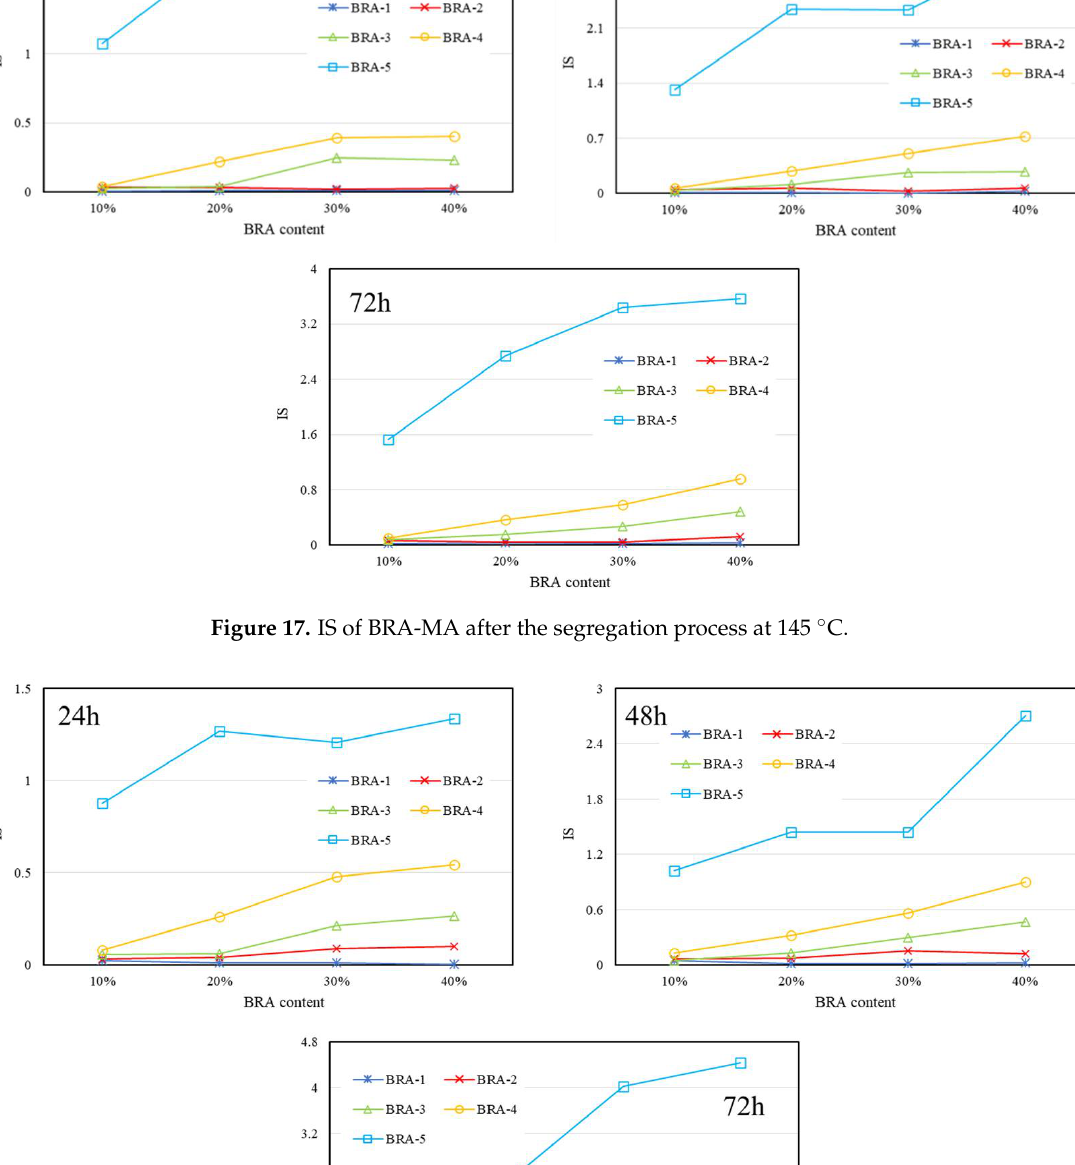
Figure 18. IS of BRA-MA after the segregation process at 155 °C.